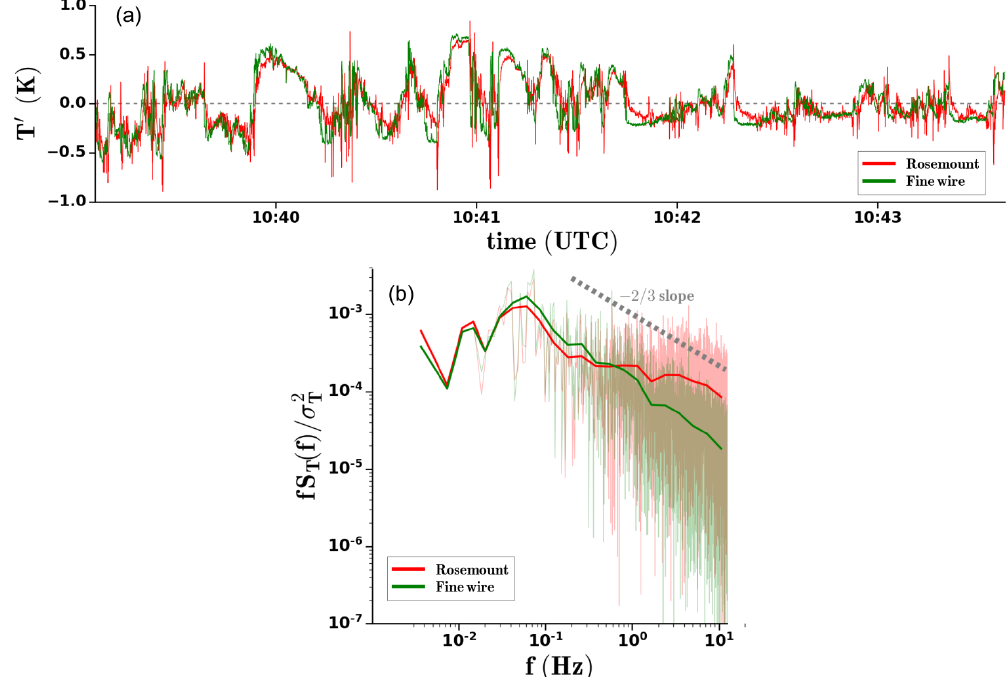
Figure 10. (a) Time series of the temperature fluctuations measured by the Rosemount probe (in red) and by the fine wire (in green) during a subcloud layer leg of RF19. (b) Corresponding density energy spectrum.